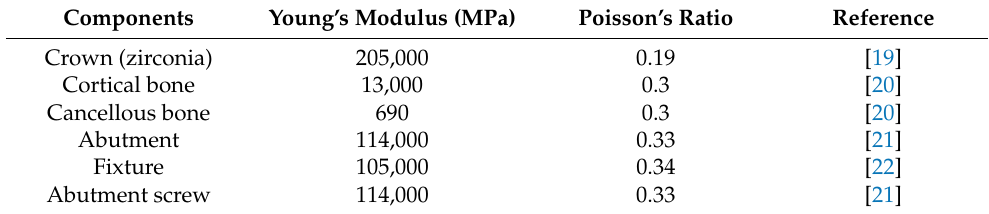
Table 1. Material properties applied to the finite element model.